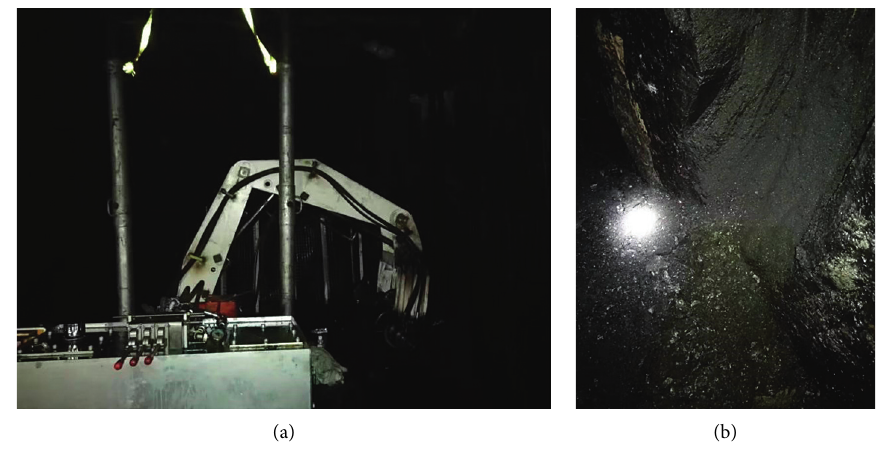
Figure 17: Coal crushing process of testing. (a) Process. (b) Effect.